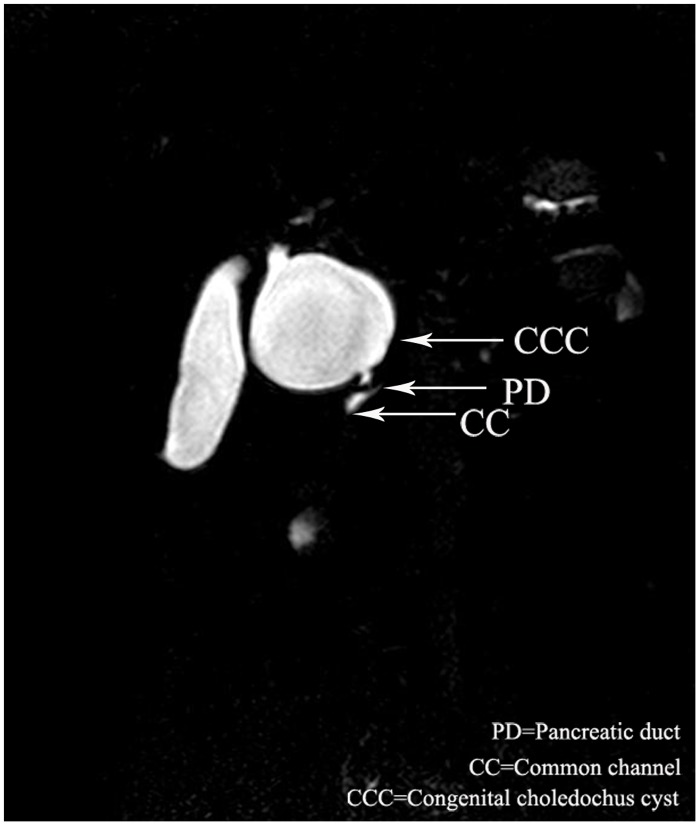
A 2-year old female with PBM, MRCP showed the spheroidal dilataion of the cyst.